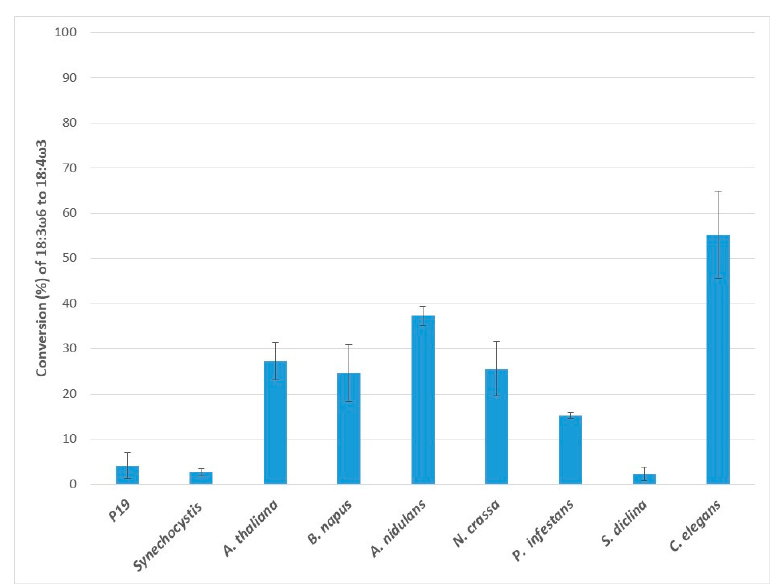
Figure 2. Enzymatic activities of transiently expressed ω 3Ds from various sources in N. benthamiana leaves on 18:3 ω 6 substrate. ω 3D activities were determined by measuring the conversion rate of provided 18:3 ω 6 substrate to 18:4 ω 3 in leaves expressing p19 silencing suppressor only as a control or the appropriate ω 3D with p19. The error bars denote the standard deviations of the means from triplicate assays.